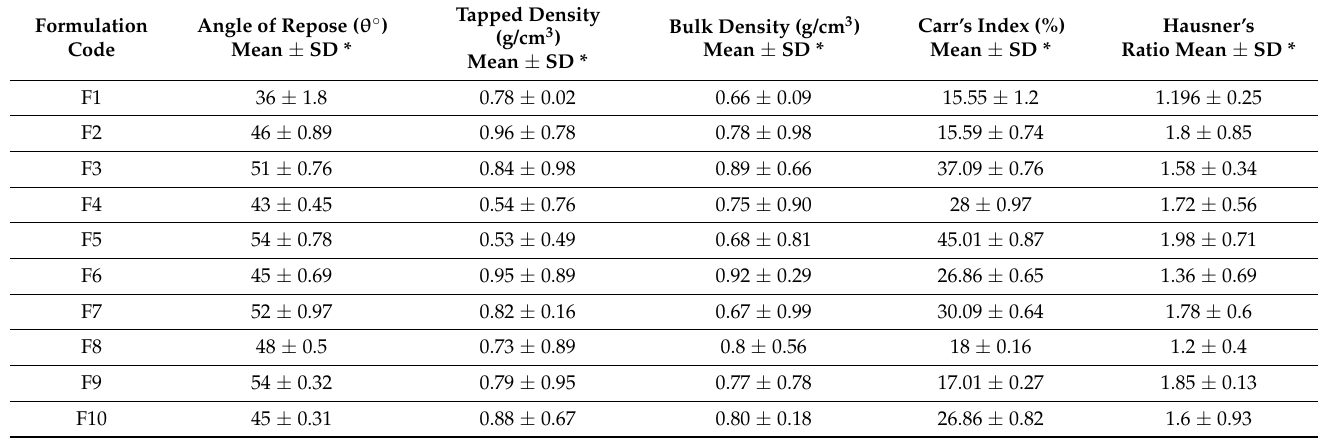
Table 2. Micromeritics of nanocarriers formulation, an average of 3 determinations ±